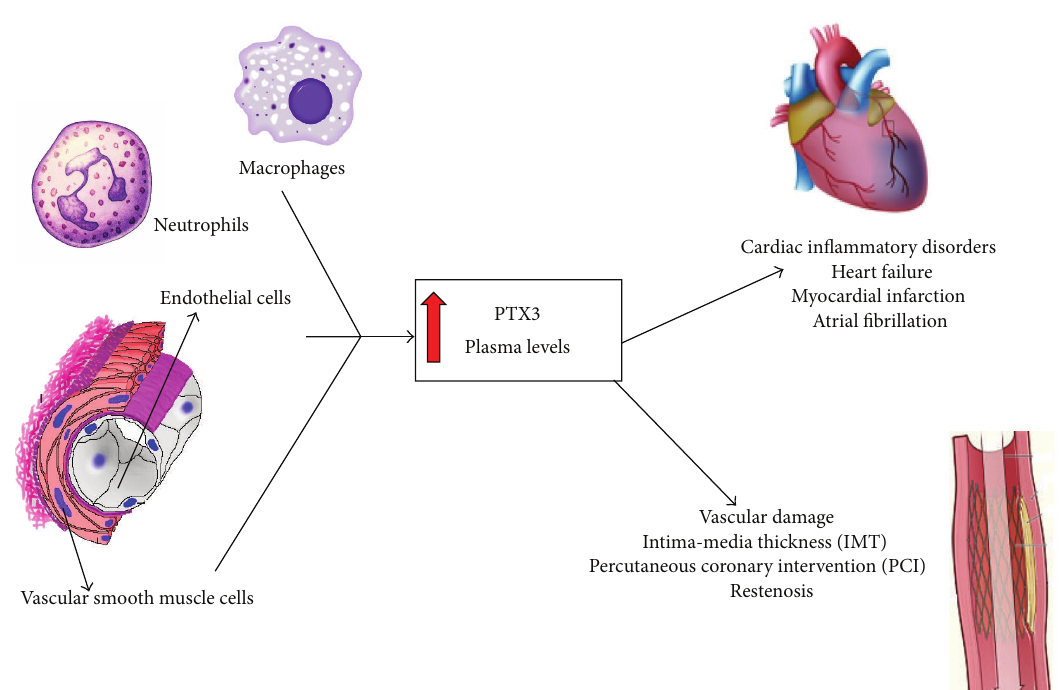
Figure 2: PTX3 as a marker of cardiovascular inflammation. A variety of cell types produce PTX3 in response to pro- and anti-inflammatory signals. Increased PTX3 levels are useful as a marker of different cardiovascular diseases including (a) cardiac inflammatory disorders, such as HF, MI, and atrial fibrillation, and (b) vascular damage, as IMT, PCI, and